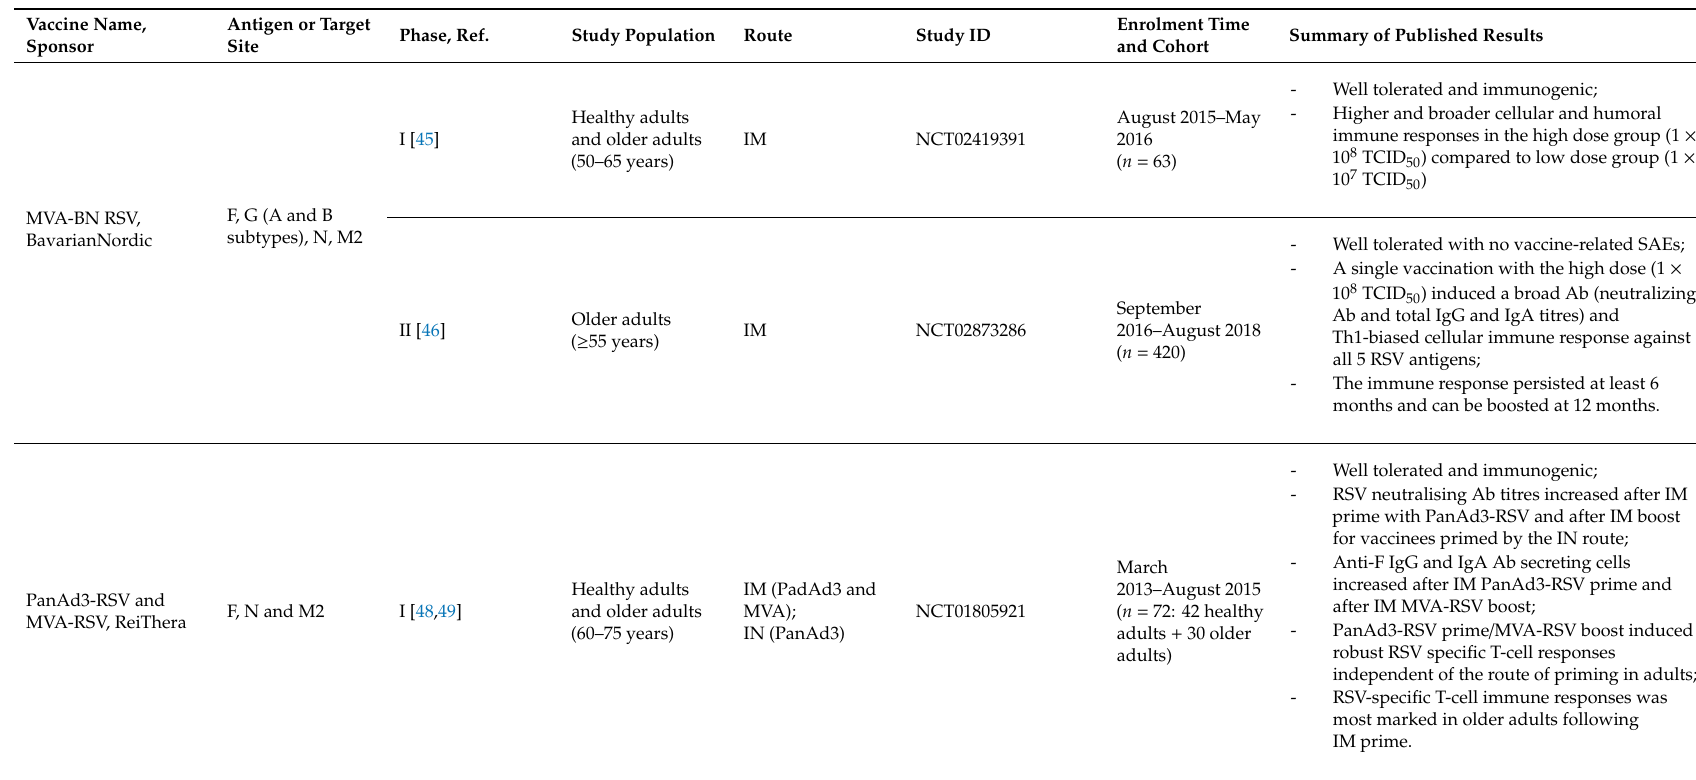
Table 3. Overview of the RSV vector-based vaccines in clinical development. Ab: antibody; ADA: anti-drug antibody; AE: adverse event; Ag: antigen; CI: confidence interval; CHD: congenital heart defect, CLD: chronic lung disease; COPD: chronic obstructive pulmonary disease; Corp: corporation; f.up: follow-up; GA: gestational age; IM: intramuscular; IN: intranasal; IV: intravenous; LRTD: lower respiratory tract disease; LRTI: lower respiratory tract infection; mAb: monoclonal antibody; NA: not available; NIAID: National Institute of Allergy and Infectious Diseases; PCA: palivizumab-competing antibody; PIV3: Parainfluenza Virus type 3; Ref: reference; RSV: respiratory syncytial virus; RT-PCR: reverse transcriptase polymerase chain reaction; SAE: serious adverse event; TCID 50 : Tissue Culture Infectious Dose 50%; vs.: